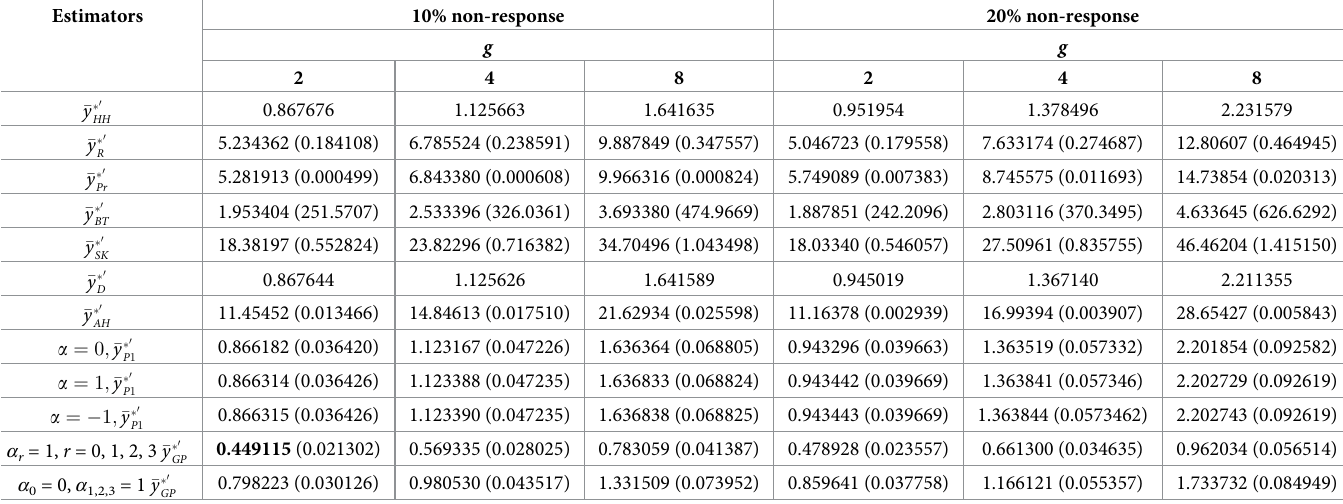
Table 13. Mean squared error and | Bias | (in brackets) values for different estimators for Population VI with measurement error. Estimators